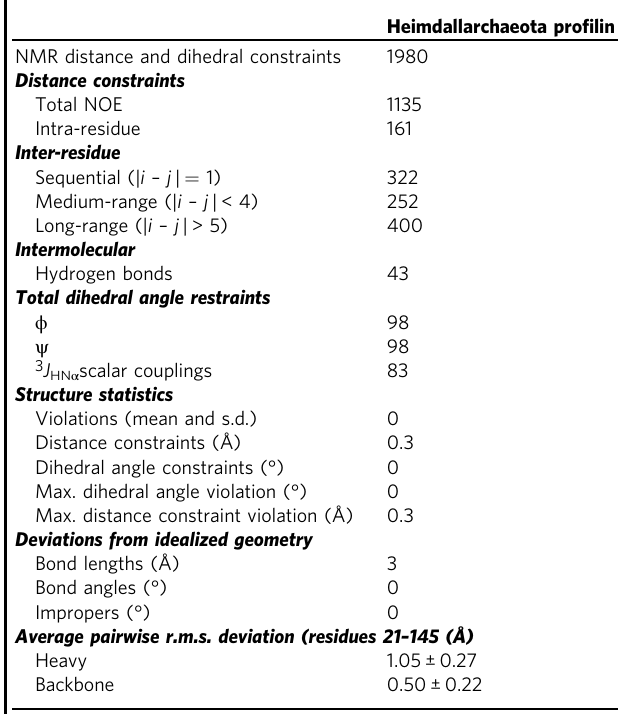
Table 1 NMR and re fi nement statistics